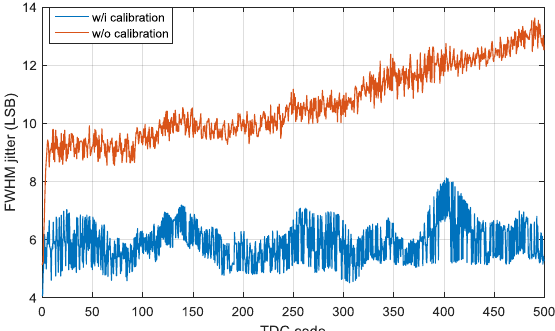
Figure 16. Jitter measurement before and after calibration, where the average jitter is reduced from 10.63 LSB to 5.87